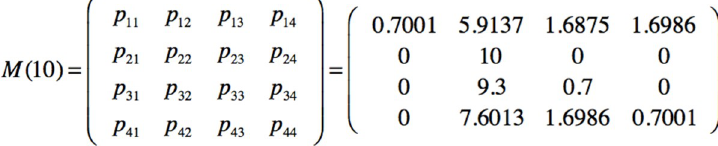
Figure 34. Number of visits for the posterior transition matrix.